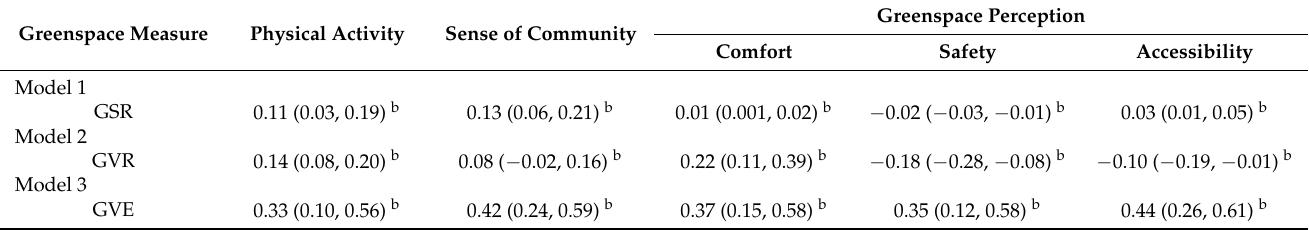
Table 9. Associations between GSE and candidate